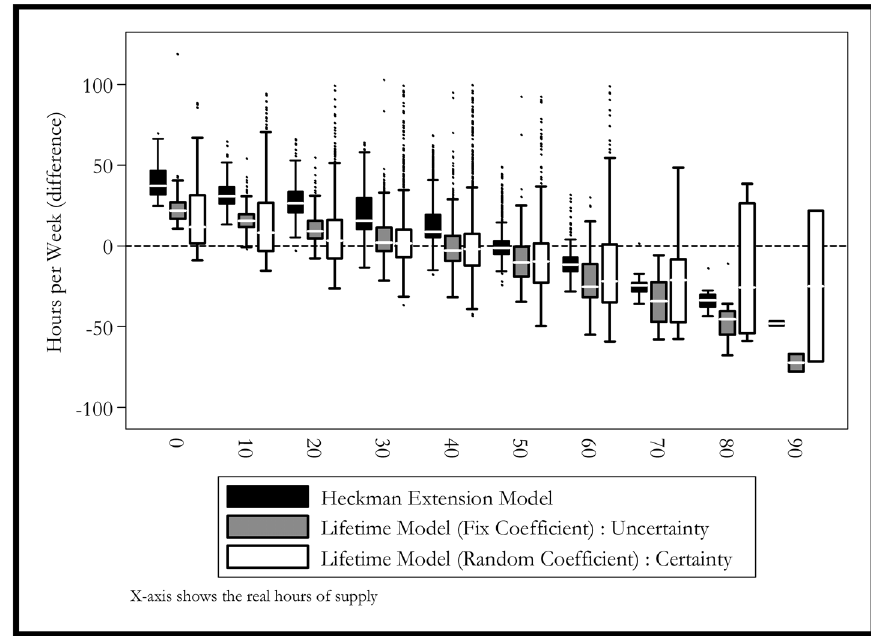
Figure 5. Simulated Distributions by Real Values of Working Hours. Black Box: Heckman Selection Model. Grey Box: Lifetime Model (Random Coefficient): Certainty. White Box: Lifetime Model (Fix Coefficient): Uncertainty.